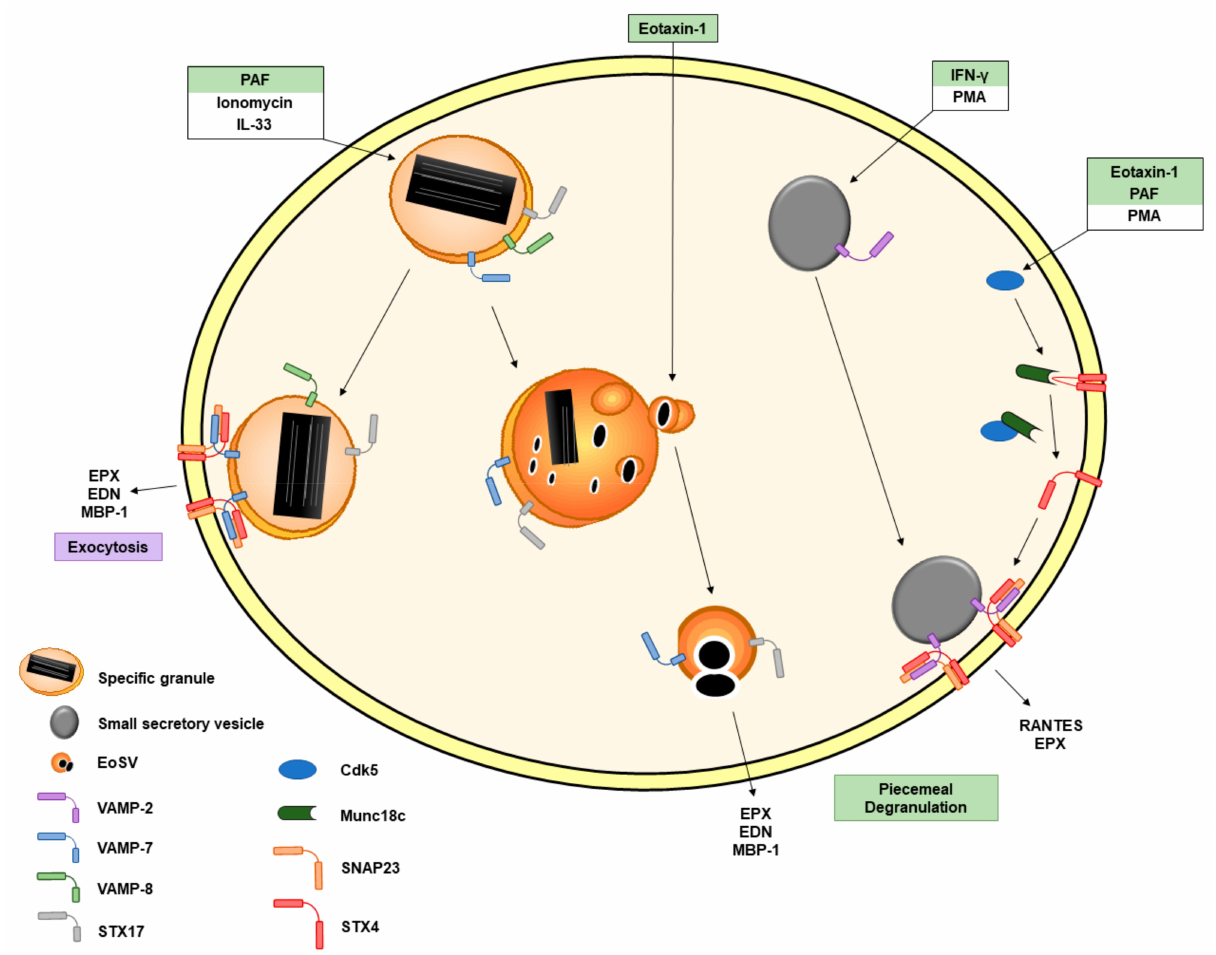
Figure 2. Schematic representation of the involvement of SNARE proteins in eosinophil degranulation. SNARE proteins are intracellularly present in eosinophils. VAMP-8 is found on specific granules. VAMP-7 is also expressed on specific granules and eoSVs. PAF, ionomycin and IL-33 are described to be involved in VAMP-7-mediated eosinophil granule protein release. Syntaxin-17 is present in specific granules and eoSVs. Eotaxin-1 leads to a significant increase in syntaxin-17 + secretory vesicles. VAMP-2 is expressed on secretory vesicles. IFN- γ induces translocation of VAMP-2 + vesicles to the plasma membrane where VAMP-2 interacts with SNAP23 and STX4. The inhibitory binding of Munc18c to STX4 is disrupted by the association of Cdk5 with Munc18c following eosinophil activation with eotaxin-1, PAF and PMA. The agonists are labelled with the color corresponding to the type of degranulation illustrated in Figure 1. Abbreviations: Cdk5, cyclin-dependent kinase 5; ECP, eosinophil cationic protein; EDN, eosinophil-derived neurotoxin; EoSV, eosinophil sombrero vesicle; EPX, eosinophil peroxidase; IFN- γ , interferon- γ ; IL, interleukin; PAF, platelet-activating factor; PMA, phorbol 12-myristate 13-acetate; PMD, piecemeal degranulation; STX4, syntaxin-4; STX17, syntaxin-17; TNF- α , tumor necrosis factor- α ; and VAMP, vesicle-associated membrane